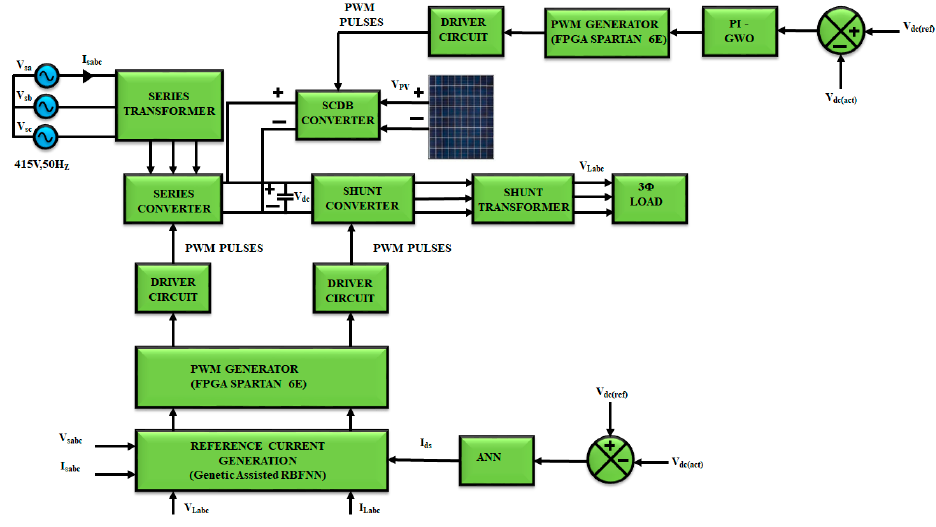
Figure 1. Proposed control methodology.